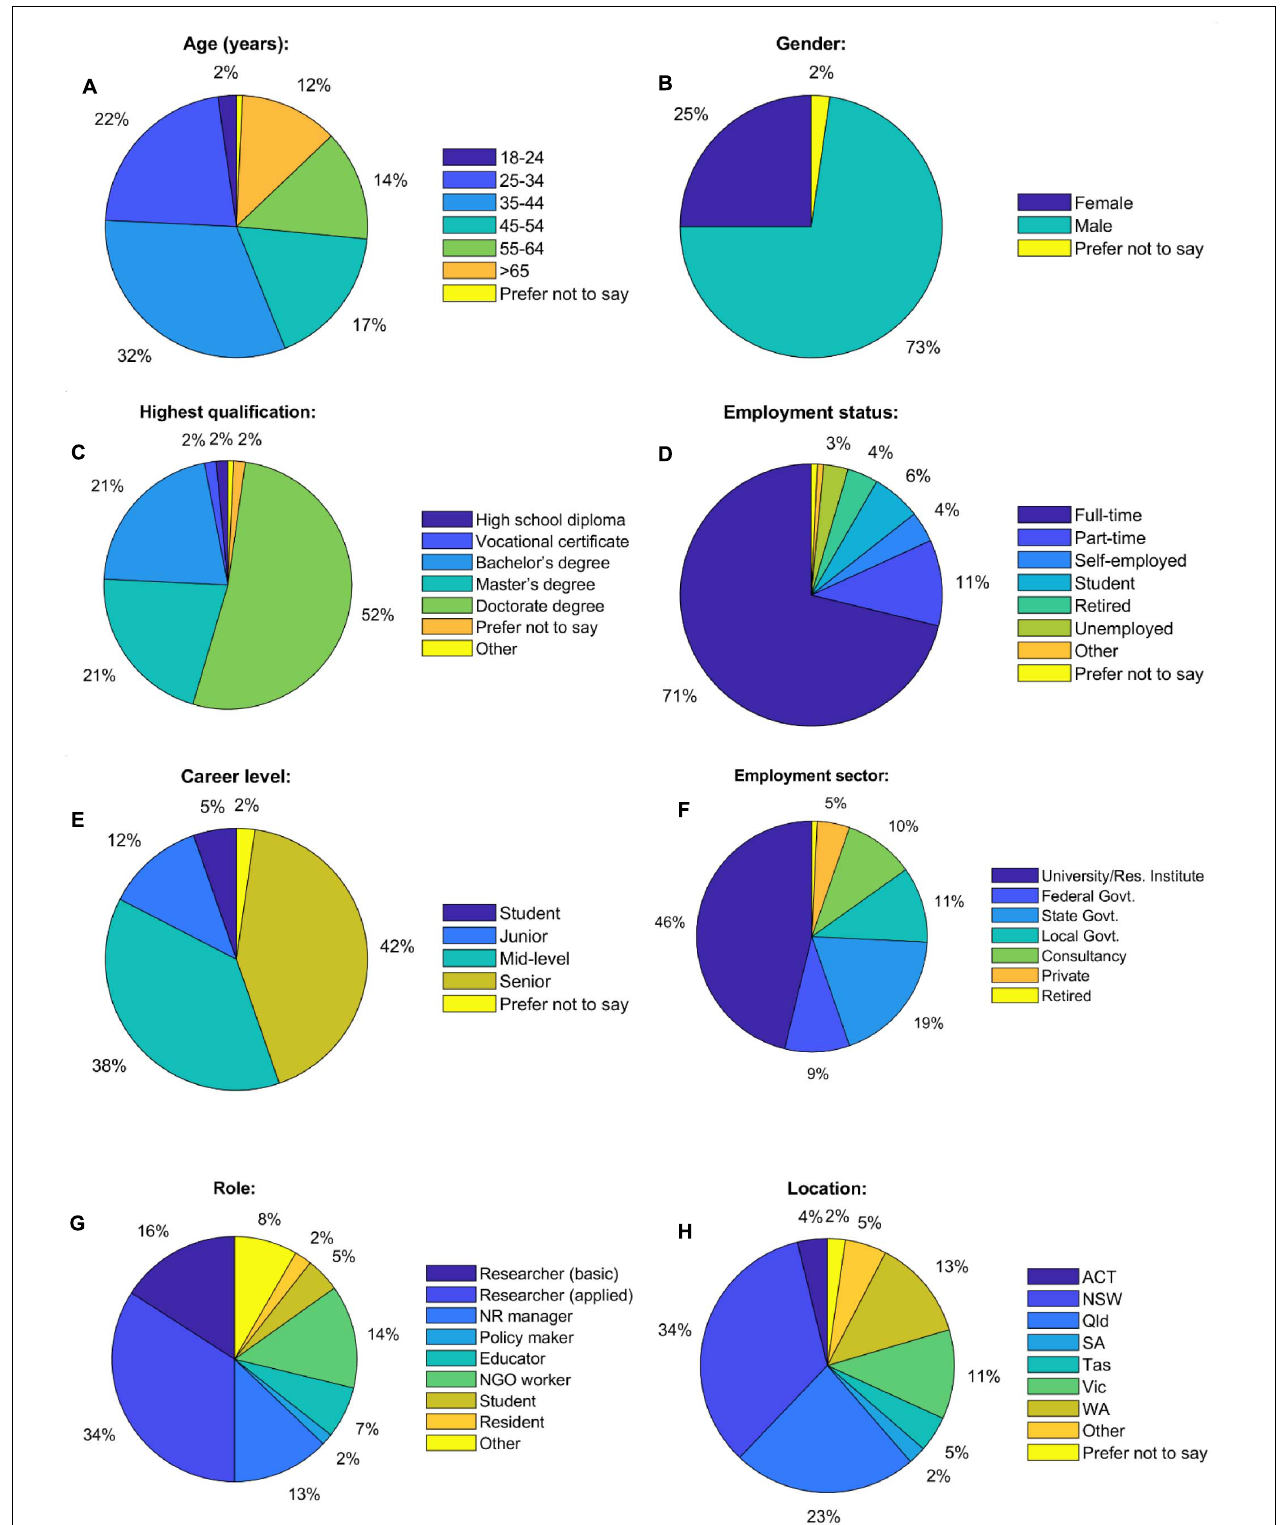
FIGURE 3 | Summary of demographics of participants in the survey in Stage 3 of the research prioritisation process. Percentages are shown for all demographic groups of 2% or greater. Panels (A–H) represent the responses to the demographic questions 2–9 in Supplementary Material 1.1 respectively.